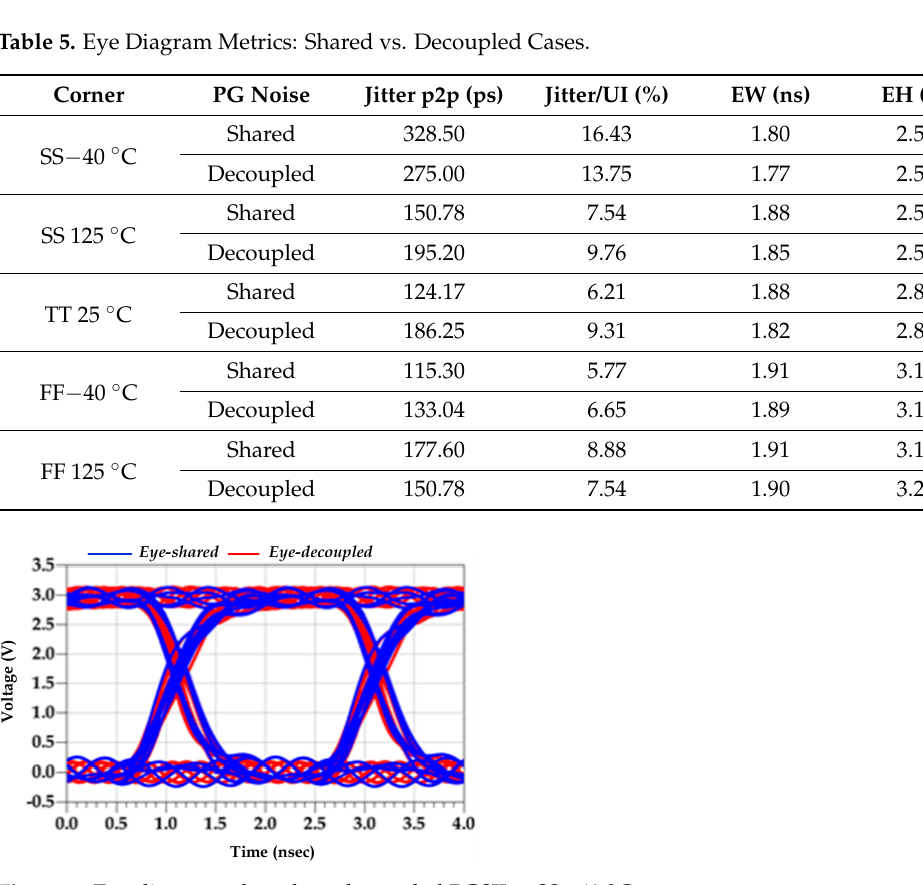
Figure 7. Eye diagram: shared vs. decoupled PGSIJ at SS − 40 °C. Table 5. Eye Diagram Metrics: Shared vs. Decoupled Cases